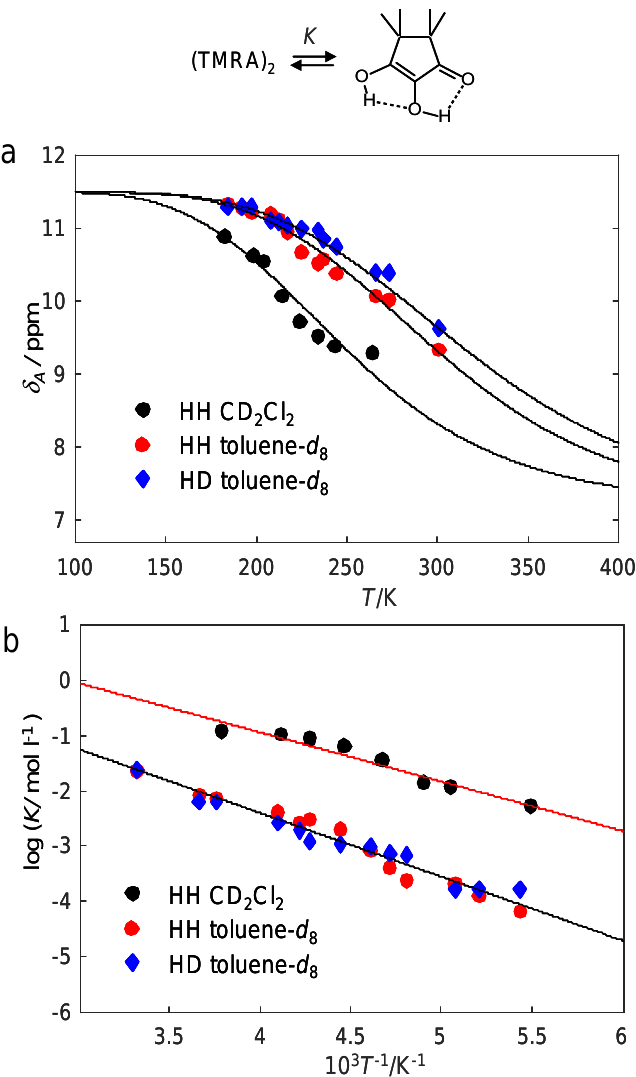
Figure 12. ( a ) Average hydroxyl chemical shifts δ A of TMRA dissolved in CD 2 Cl 2 (sample #1) and in toluene- d 8 (samples #2 and #3) as a function of temperature. The solid lines were calculated in a similar way as those described in Figure 6, but adapted to the experimental data for the determination the dimer–monomer dissociation enthalpies and entropies ∆ H and ∆ S . The values of δ A1 and δ A2 were the same as in Figure 11 and included in Table 3. ( b ) Van’t Hoff plot of the equilibrium constants K of dissociation obtained from the experimental values of δ A using Equation (6). For further explanation see text.